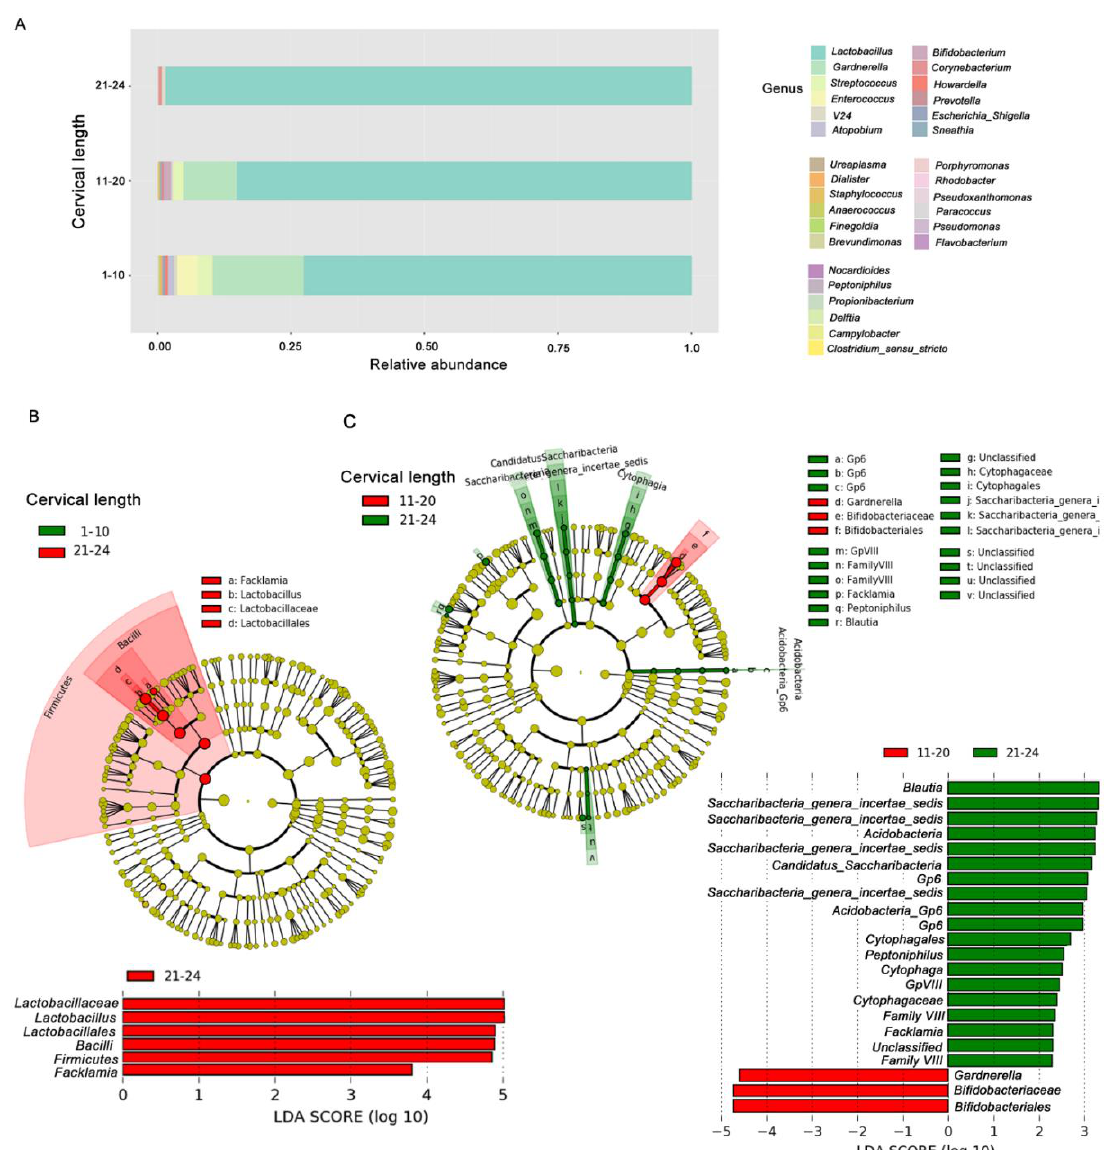
Figure 3. Microbiome profiles in vaginal samples according to cervical shortening categorization. ( A ) Barplot of vaginal swab samples was stratified based on cervical shortening (1 – 10 mm, 11 – 20 mm, 21 – 24 mm). The percentage of bacterial relative abundances (average) at the genus level is showed. ( B , C ) Metagenomic biomarker discovery by linear discriminant analysis effect size (LEfSe) analysis. Comparison of enriched taxa between vaginal samples of women with cervix length ( B ) 1 – 10 mm vs. 21 – 24 mm, and ( C ) 11 – 20 mm vs. 21 – 24 mm. Results indicated the statistically significant taxa